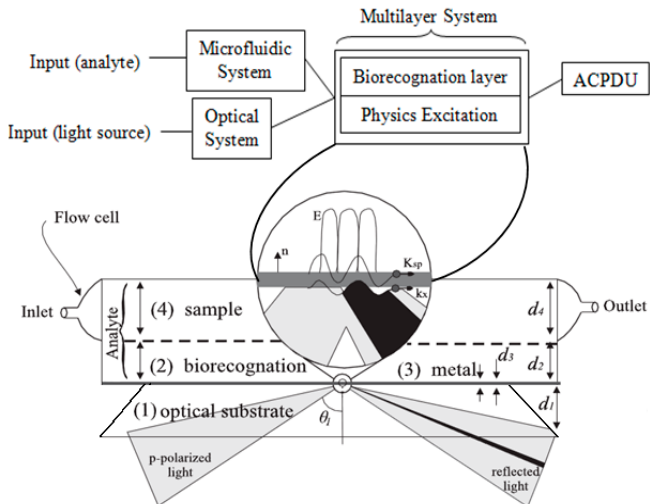
Figure 1. Block diagram of a surface plasmon resonance biosensor which comprises 4 different systems: Microfluidic, Optical, a Multilayer structure and ACPDU (Acquisition Control Processing and Display Units). Details for a typical SPR biosensor multilayer structure, whose the analyte is admitted through the